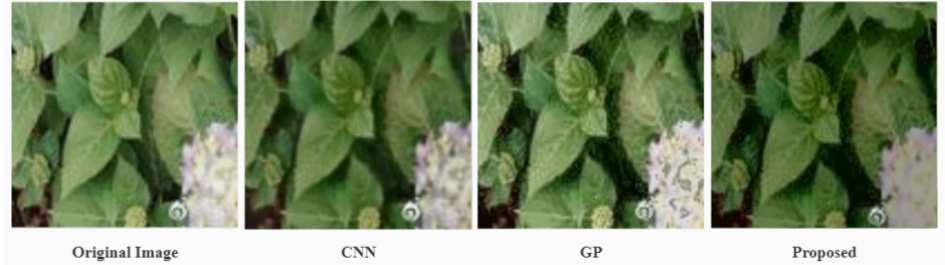
Figure 8. The comparison in details of GP, CNN, and our